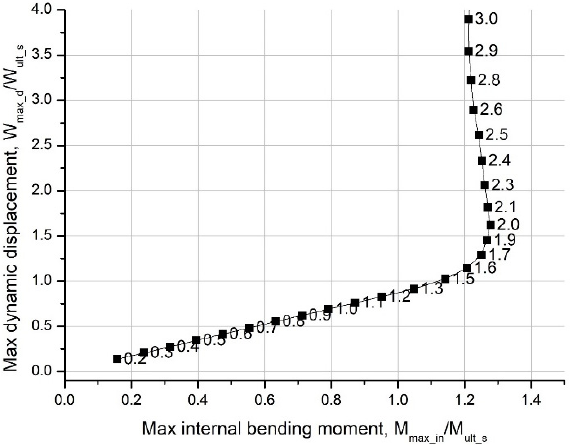
Figure 16. Internal bending moment and vertical displacement for mid-span box girder M3 at load